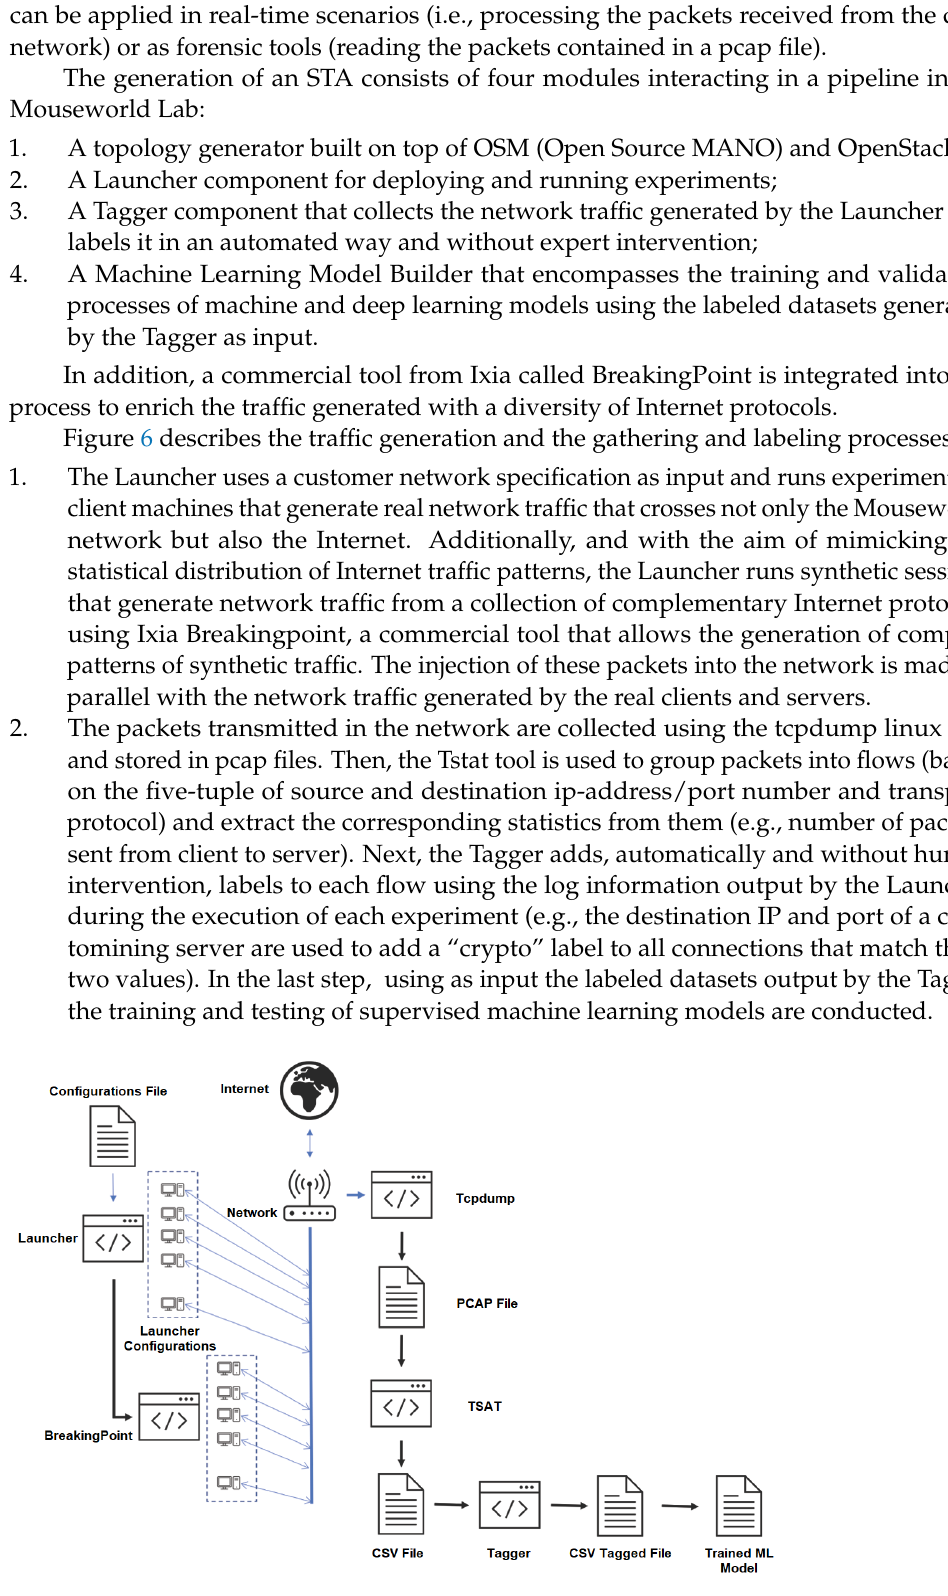
Figure 6. Traffic generation and